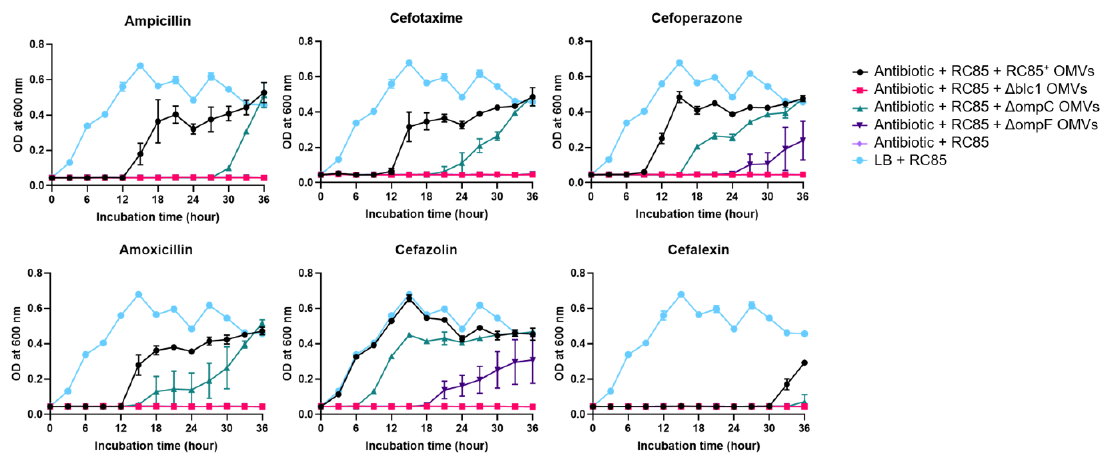
Figure 5. Growth of β -lactam-susceptible Escherichia coli (RC85) cells in antibiotic-induced growth inhibition environment to evaluate the antibiotic consumption role of intact OMVs from RC85 + and isogenic mutant strains. The growth-inhibiting concentrations of β -lactam antibiotics were: ampicillin, 30 µ g / mL; cefotaxime, 1.25 µ g / mL; cefoperazone, 4 µ g / mL; amoxicillin, 12 µ g / mL; cefazolin, 8 µ g / mL; cefalexin, 16 µ g / mL. The data are presented as means and SEMs of three independent experiments.